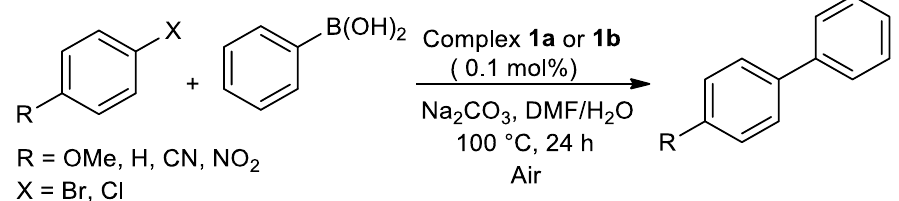
Figure 4. Representative metal complexes of thiosemicarbazones as catalysts for the Suzuki–Miyaura and other coupling reactions (Part C).